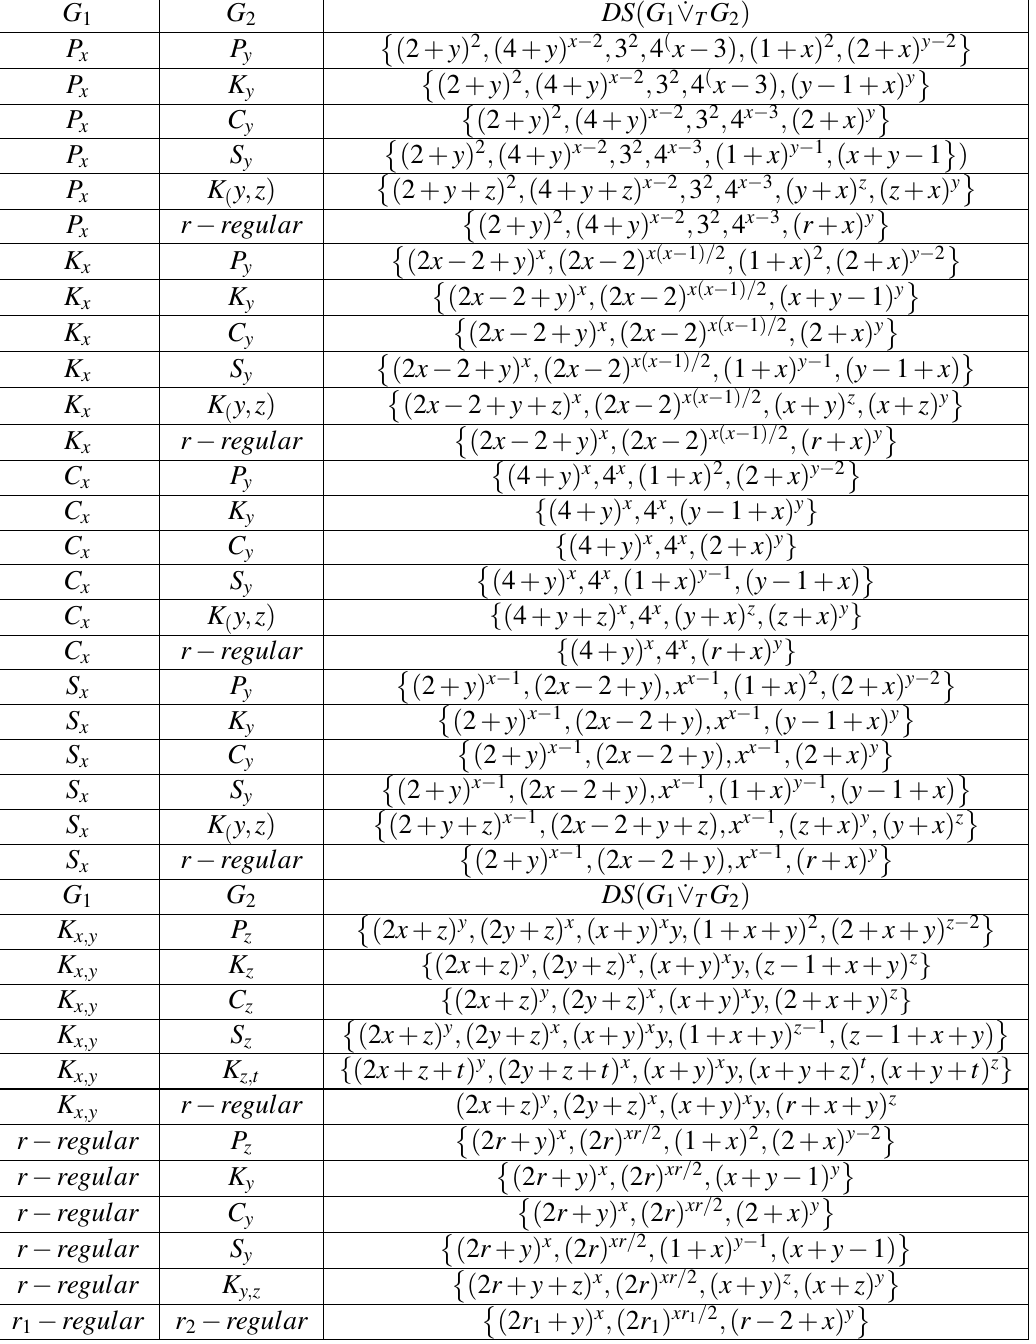
Table 5 Degree sequence of vertex- T join graph for path, complete graph, cycle, star, complete bipartite and r − regular